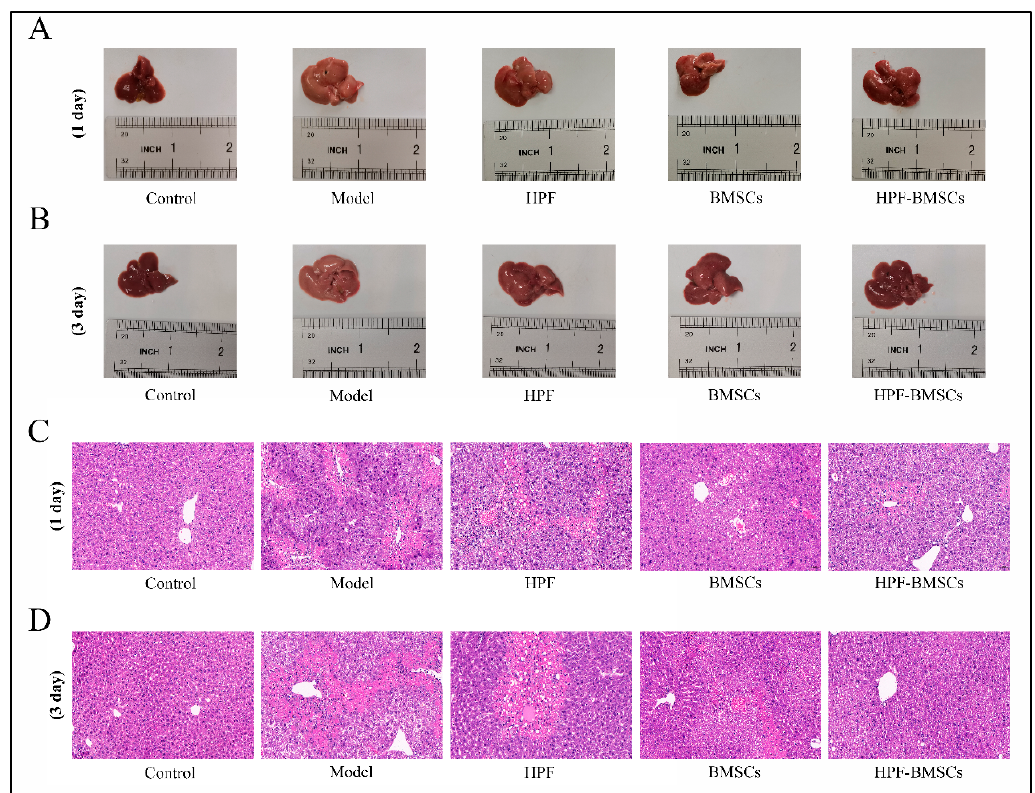
Figure 6. HPF combined with BMSC treatment improved hepatic pathological changes in mice with CCl 4 -induced liver injury. ( A , B ) Morphology of the liver tissues in each group. ( C , D ) The representative images of HE staining. Scale bars: 50 µ m.